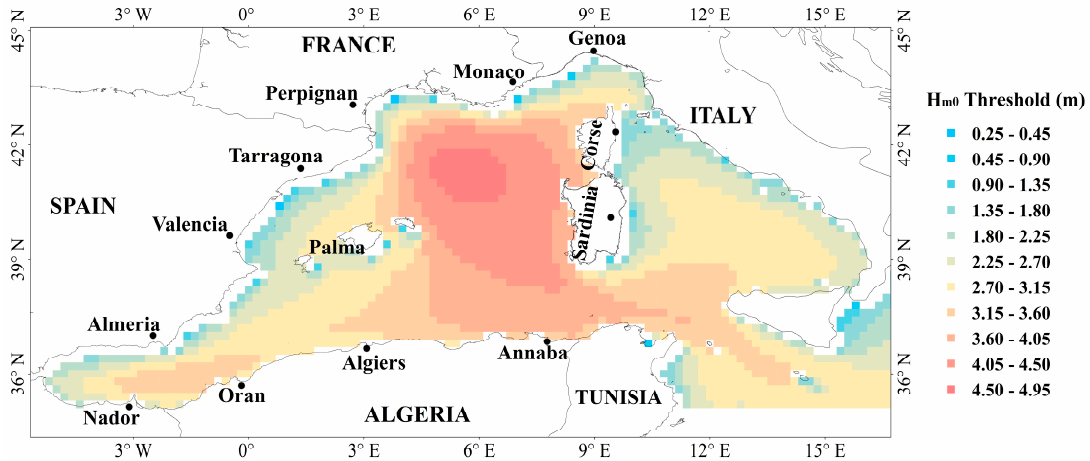
Figure 1. Significant wave height thresholds used for the characterization of storm wave events.